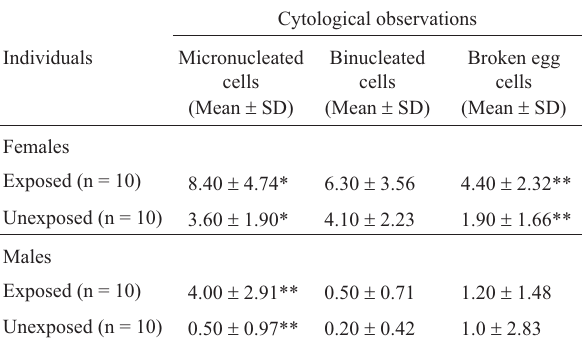
Table 4 - Cytological observations made on 10 males and 10 females occupationally exposed to cathode ray tube computer video display monitors (VDMs) as compared to unexposed control individuals matched for age and sex. We assessed 2,000 cells for each individual. Cytological observations